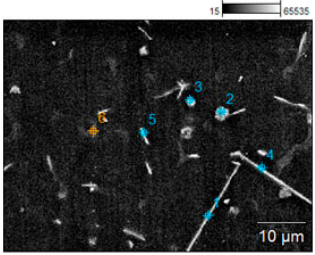
Figure 2. SEM images of AZ91-1.0%Pr die-casting alloys.